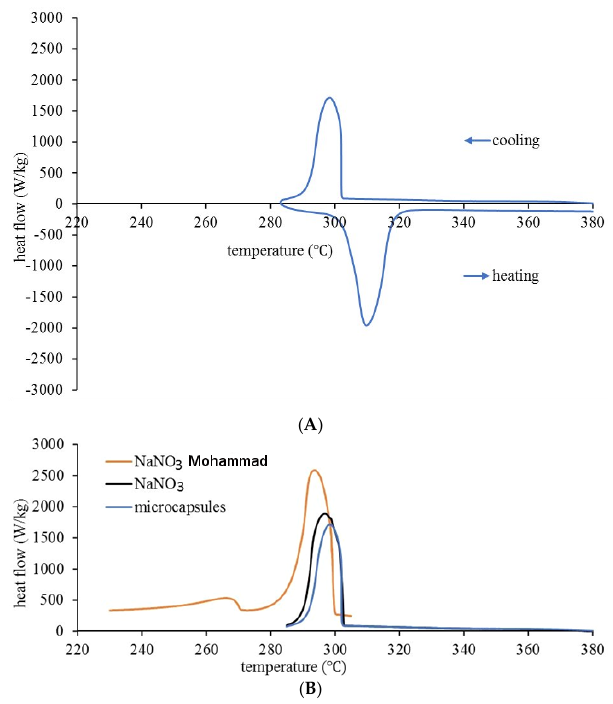
Figure 3. ( A ) DSC heating - cooling curves for NaNO 3 –ZnO microcapsules. ( B ) Comparison of DSC solidification curves (10 °C /min cooling rate) for pure NaNO 3 (Mohammad [5] and own data) and microcapsules.